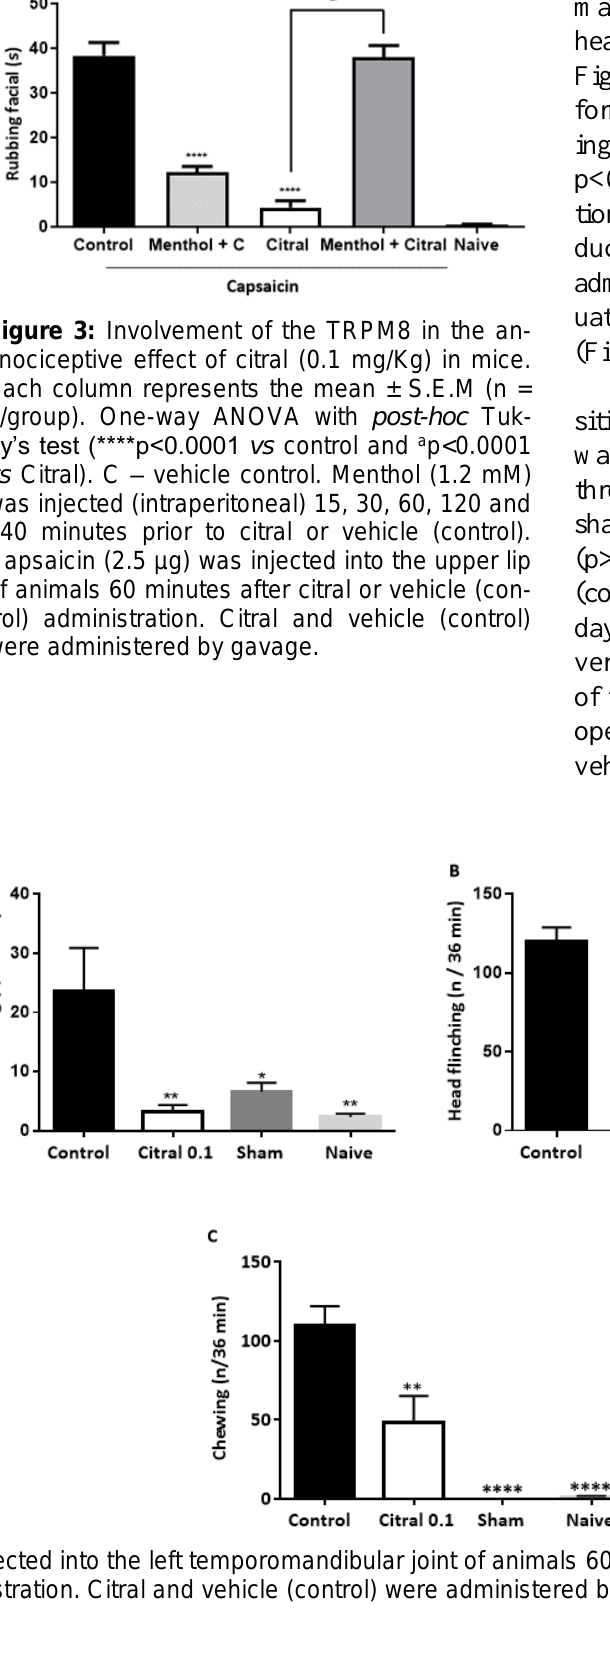
jected into the left temporomandibular joint of animals 60 minutes after citral or vehicle (control) admin- istration. Citral and vehicle (control) were administered by